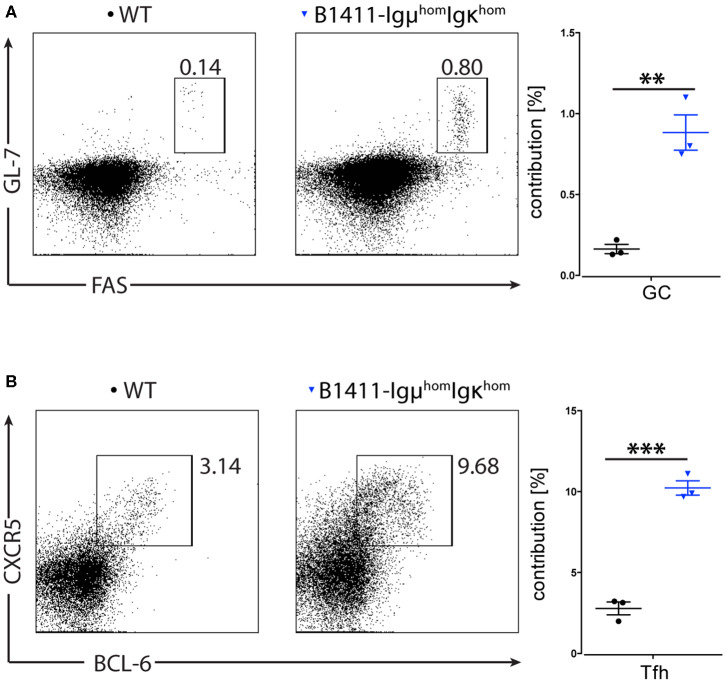
Spontaneous Germinal Center reaction. Flow cytometric analysis of germinal center (GC) B220+ B cells (A) and CD4+ T follicular helper (TFH) cells (B) in the spleen of WT NOD and B1411-IgμhomIgκhom mice in the absence of any stimulation (left). Scatter dot plot showing frequencies of TFH and GC B cells in WT NOD (black circles) and B1411-IguhomIgkhom (blue triangle). ***indicates p-value < 0.001. ** indicates p-value < 0.01. Error bars are expressed as mean ± SEM.